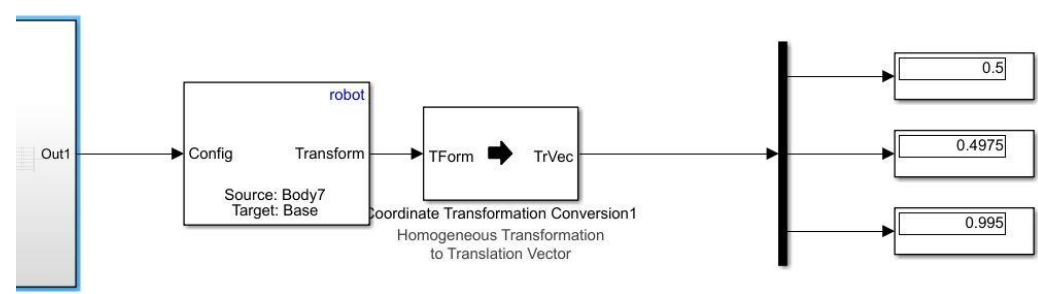
Figure 7. Output Display